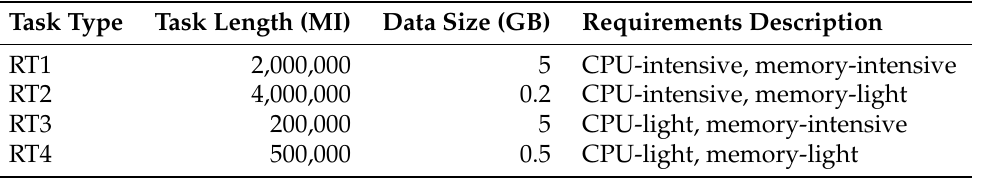
Table 1. Types of read tasks and their processing requirements.